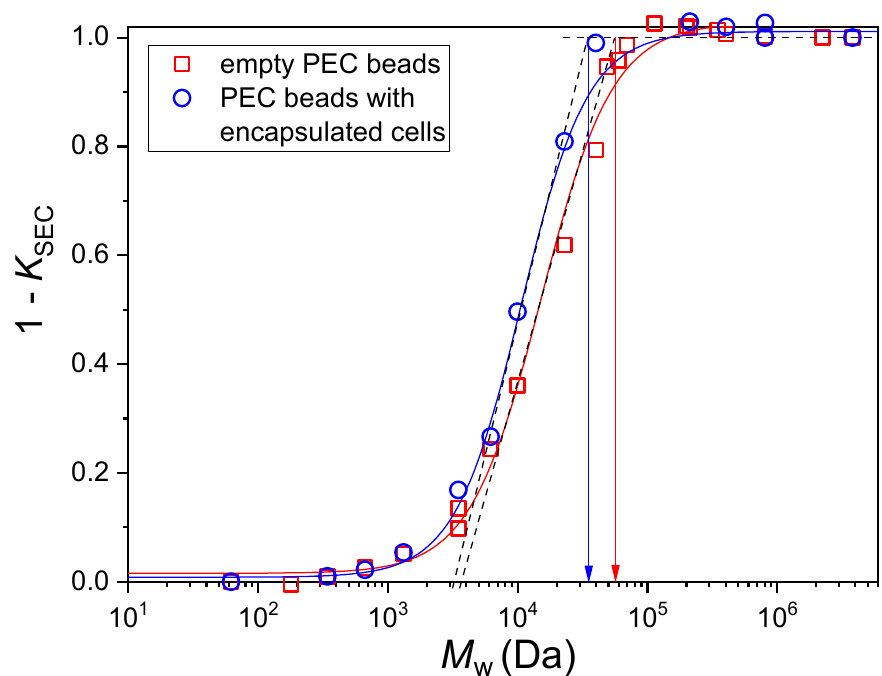
Figure 5. Cumulative pore size distributions determined by an inverse size-exclusion chromatography for PEC empty beads and entrapped E. coli cells expressed by the experimental data (1 − K SEC ), where K SEC represents the chromatographic partition coefficient against the molecular weight of pullulan standards. The data were fitted with the Boltzmann function. The matrix molecular weight cut-off (MWCO) values for respective bead types are marked by arrows and were determined following the work of Brissova et al. [25].